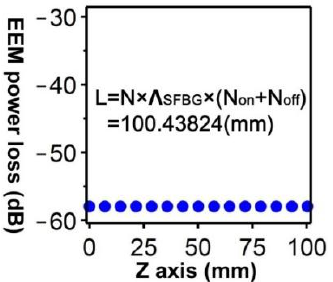
Figure 7. Relationship between power loss resulting from using the EEM and applying the SFBG length in the 40 guided modes.